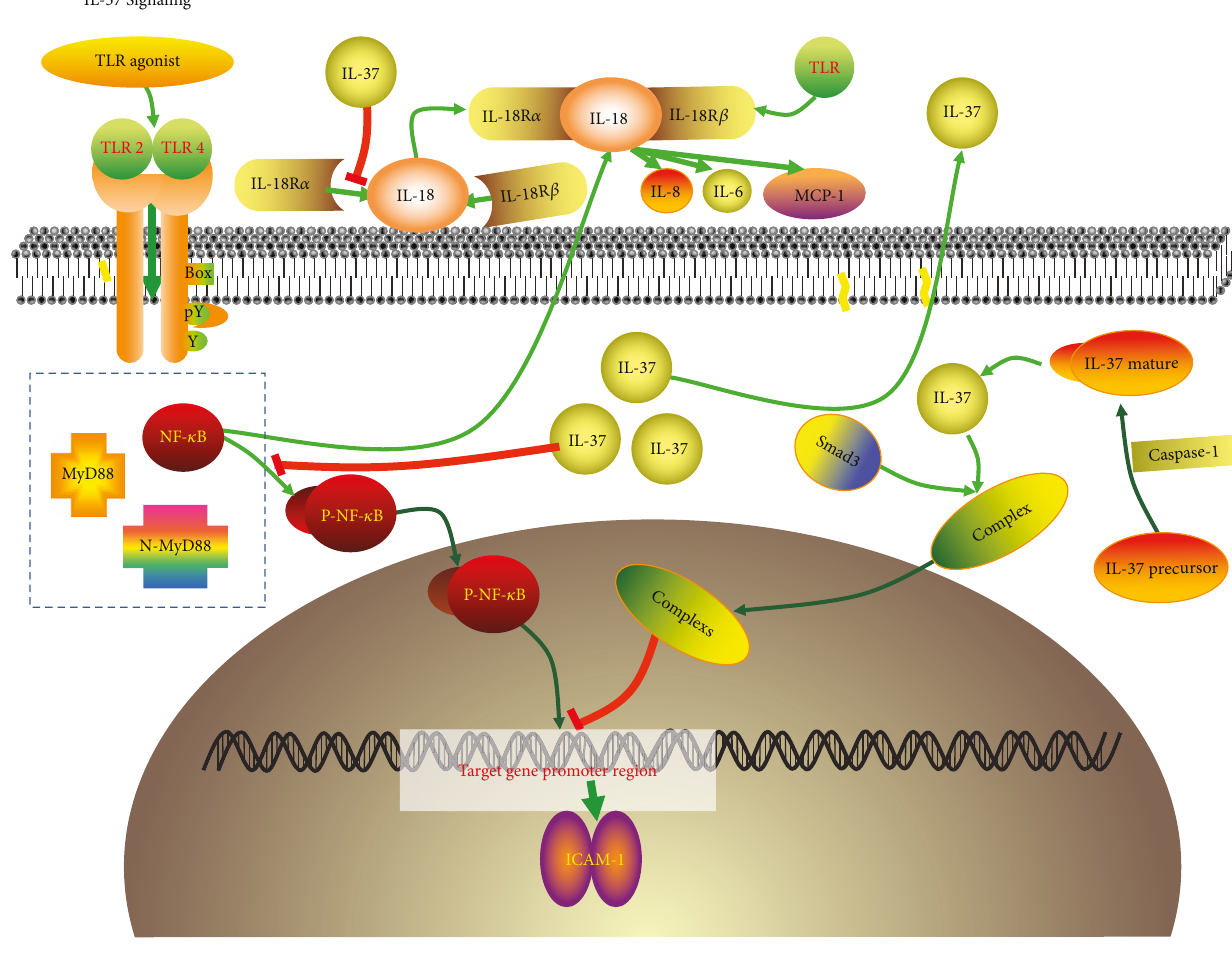
Figure 3: IL-37 signaling pathway induced by TLR2/4 extracellularly and intracellularly. The translocation of the activated NF- κ B induced by TLR2/4 into the nucleus for binding to NF- κ B-speci fi c DNA-binding sites, resulting in the regulation of the transcription of target genes, such as ICAM-1. On one hand, IL-37 can inhibit the TLR2/4-NF- κ B signaling pathway by suppressing the phosphorylation of NF- κ B or binding to Smad3 to inhibit transcription in the nucleus. On the other hand, IL-37 can combine with IL-18R α side chain to prevent the formation of IL-18 functional complex to suppress the production of proin fl ammatory cytokine